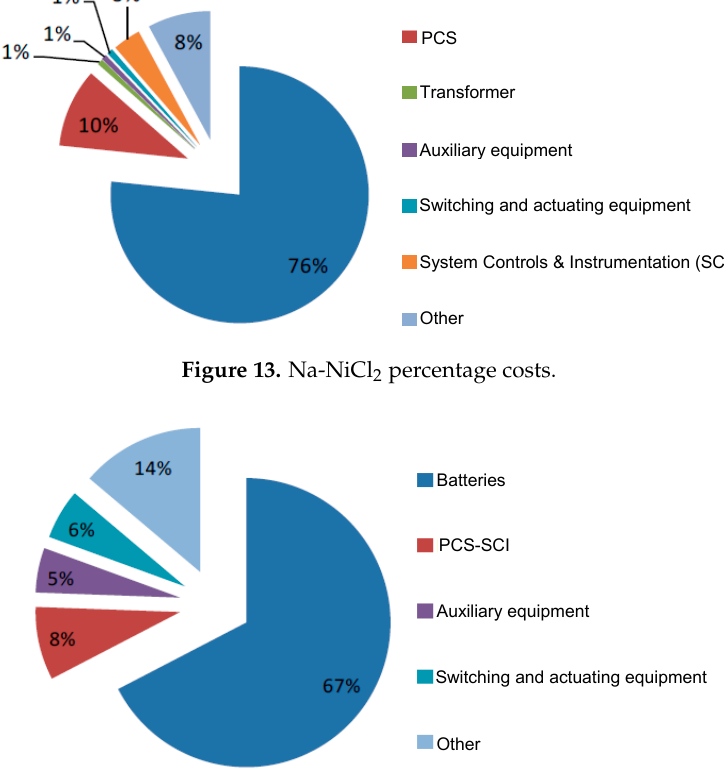
Figure 14. Na-S percentage costs.